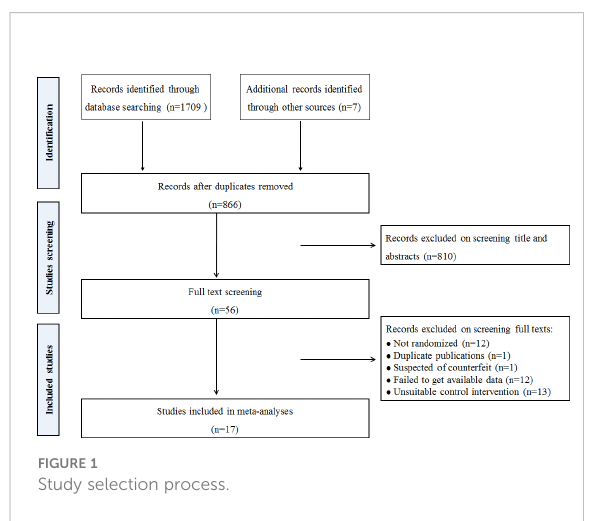
FIGURE 1 Study selection